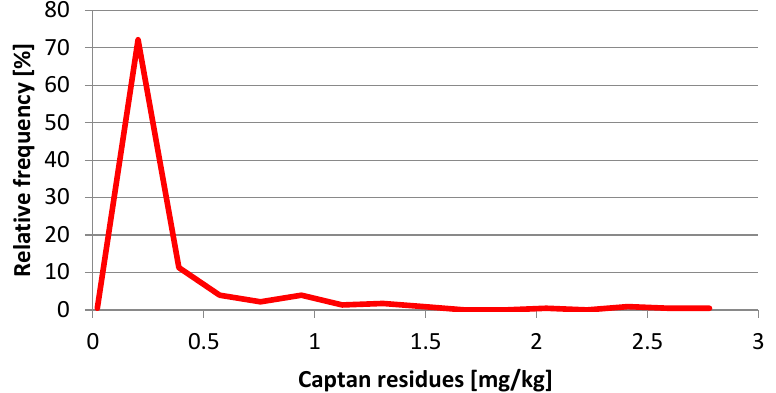
Figure 4. Captan residues (271) in composite samples of size 10 – 12.